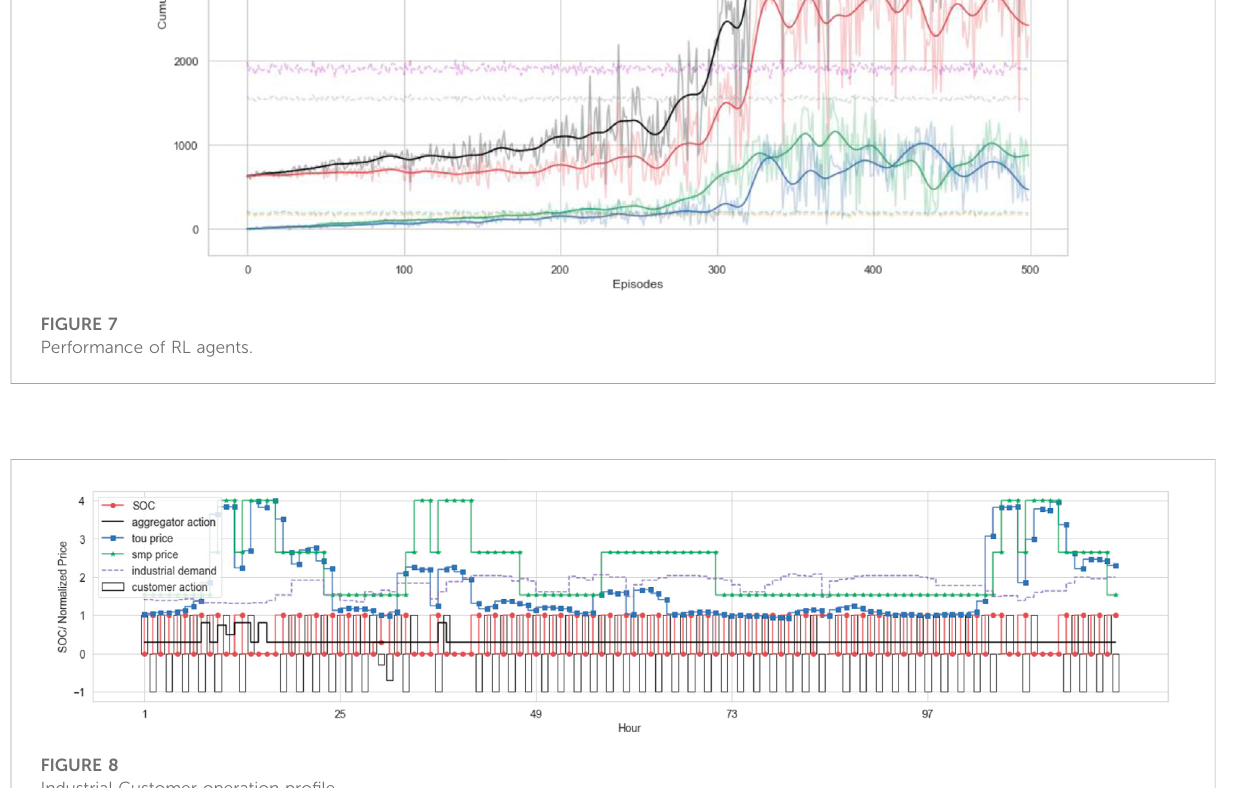
FIGURE 8 Industrial Customer operation pro fi